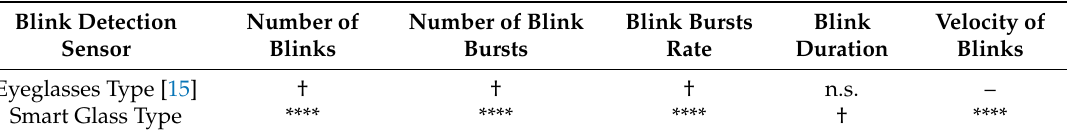
Table 1. Summary of the candidates for fatigue index.